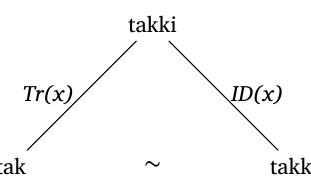
Figure 11: Initial-CVC reduplication as a concatenation of